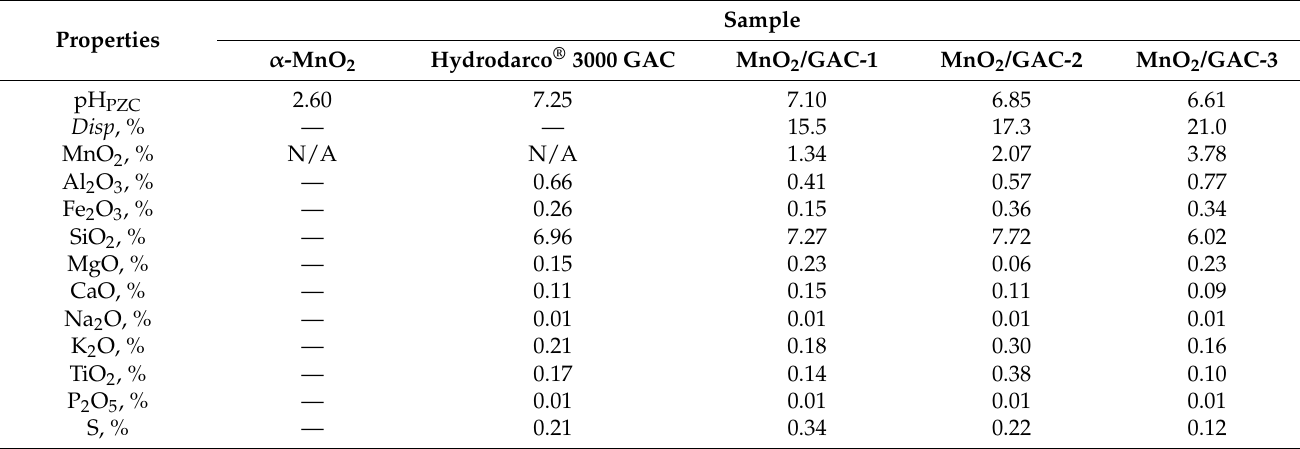
Table 3. Analysis and chemical properties of the synthesised α -MnO 2 nanoparticles, commercial activated carbon Hydrodarco ® 3000, and the three MnO 2 /GAC composites prepared in this